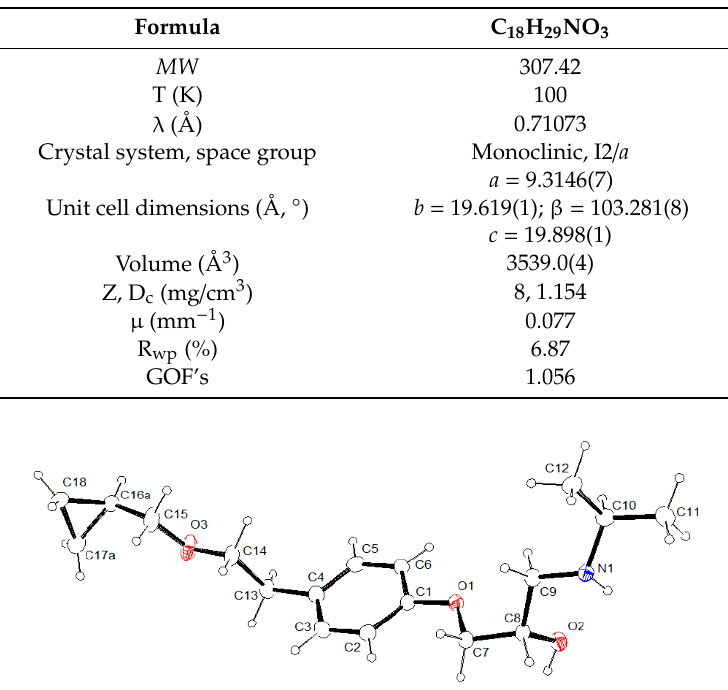
Figure 1. ORTEP-3 view of the betaxolol molecule BE_IV . For sake of clarity only the set of coordinates having the highest occupancy factor has been reported (occupancy factor 74%). Table 1. Crystallographic data and refinement parameters for BE_IV .